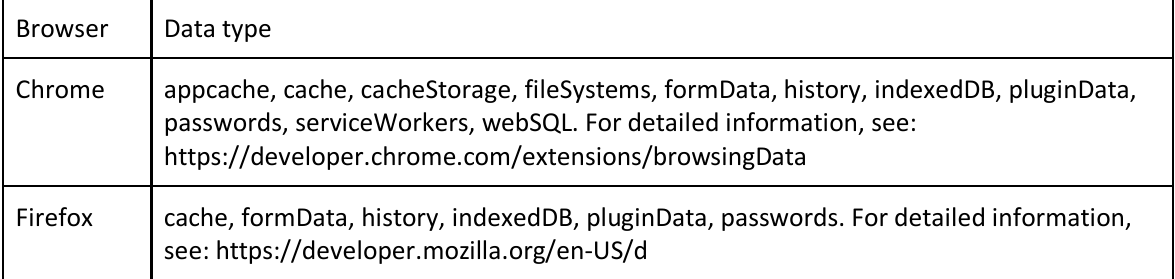
Table 1. Types of data that were cleaned after each query